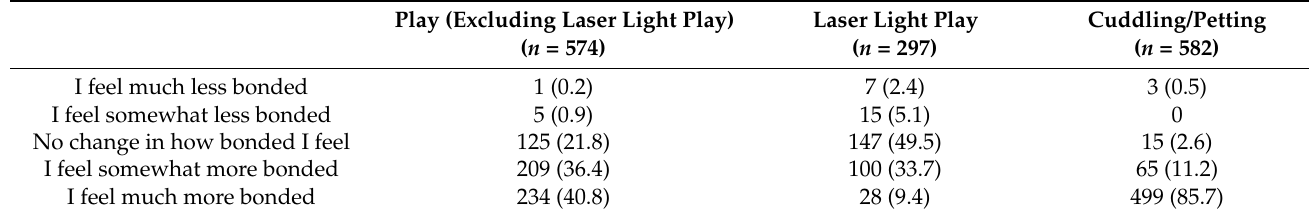
Table 3. Guardian reported bond feelings after cat interactions.